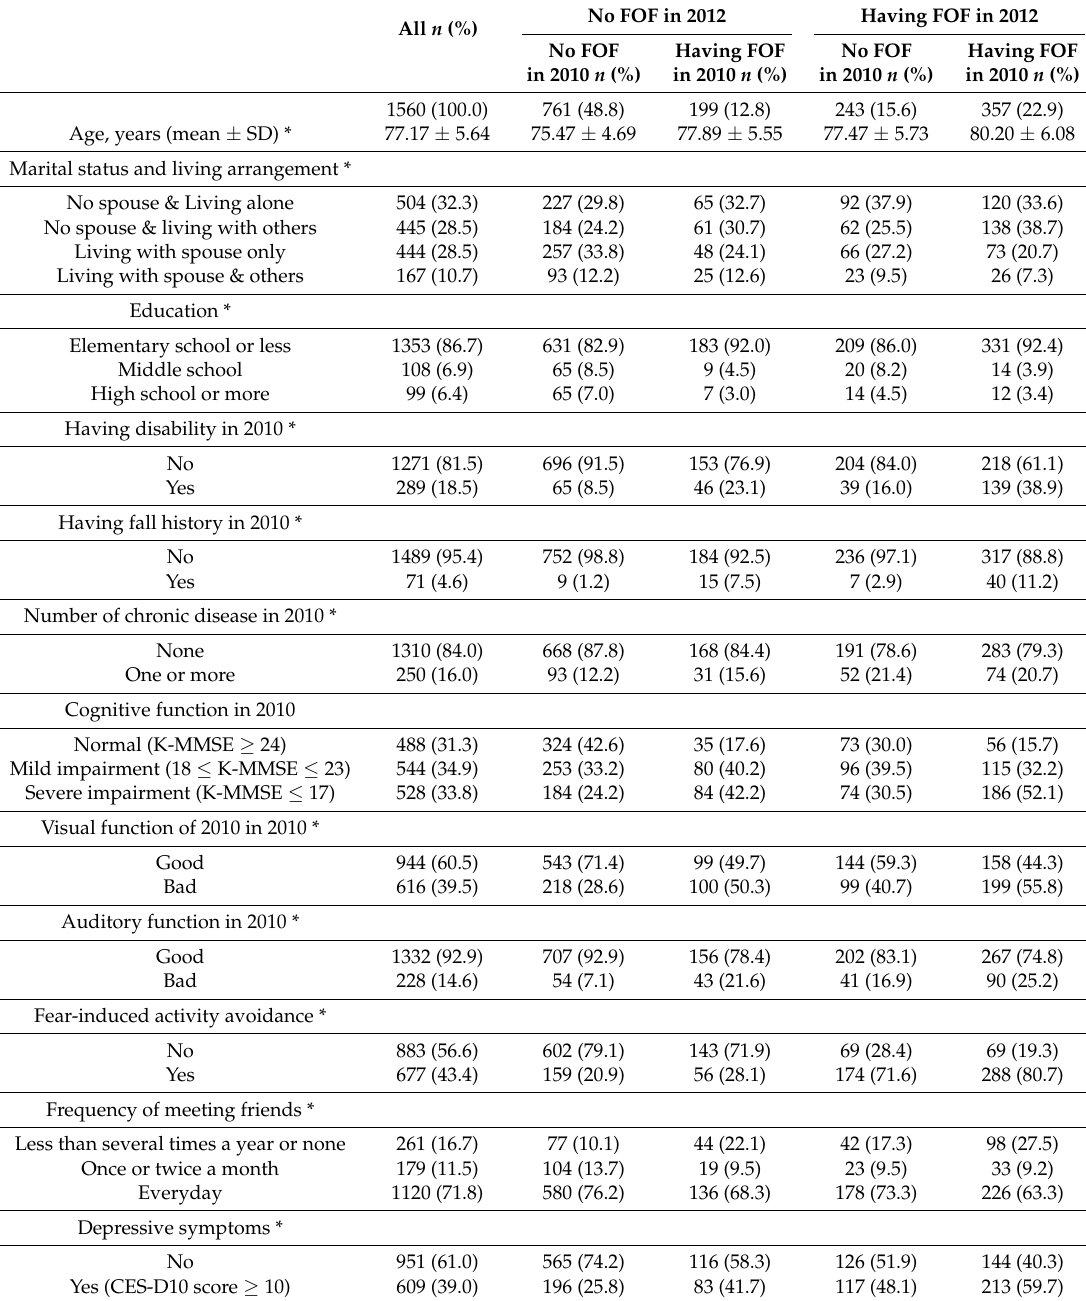
Table 1. Distribution of socio-demographic and health related characteristics by different fear of falling status among Korean older women aged 70 years or